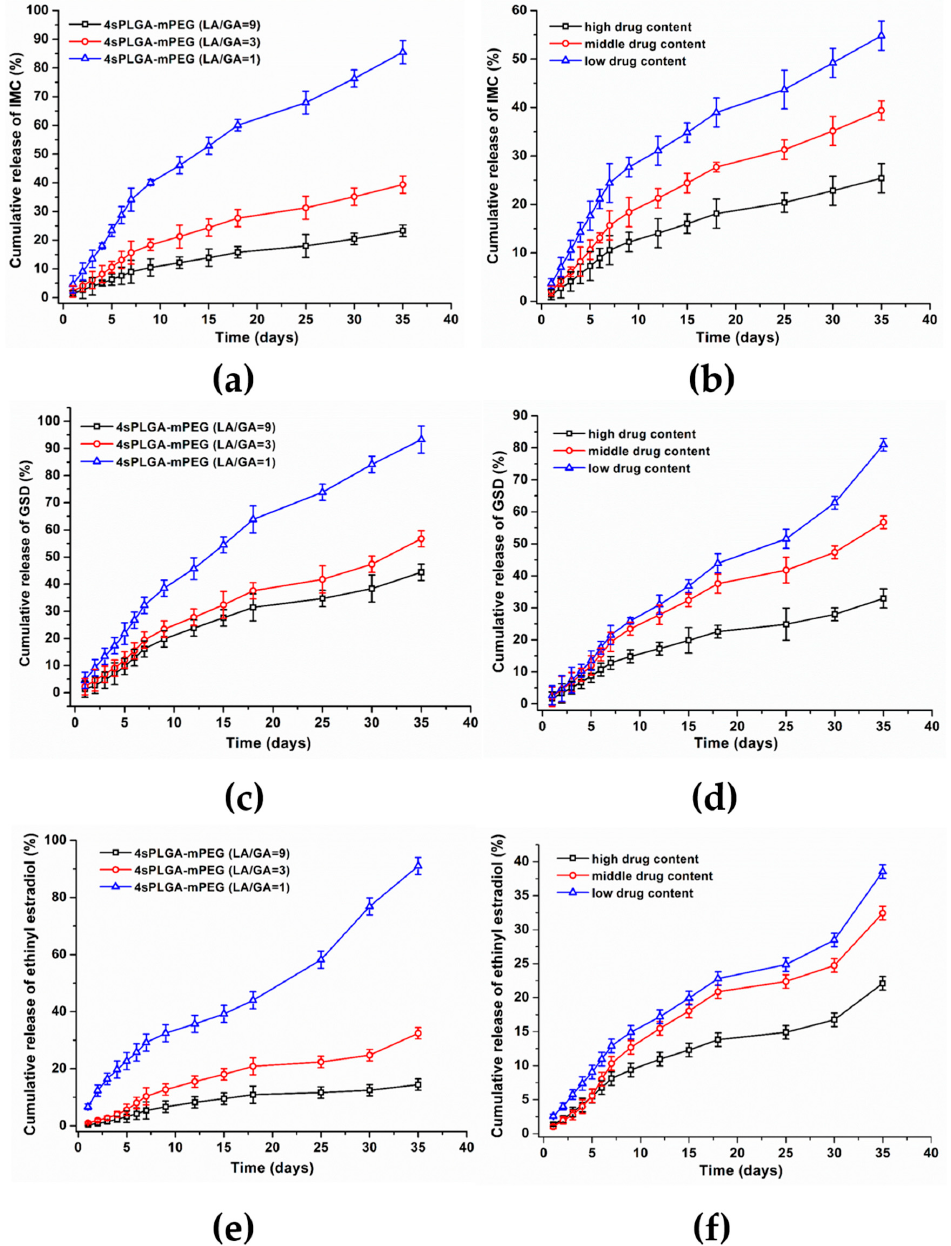
Figure 3. The release profiles of indomethacin (IMC), gestodene (GSD), and ethinyl estradiol (EE) prepared 4sPLGA-mPEG block copolymer hydrogels. Cumulative release of IMC ( a ), GSD ( b ), and EE ( c ) packed by copolymer hydrogel with the same middle drug content and various lactide / glycolide (LA / GA) mol ratios. Cumulative release of IMC ( d ), GSD ( e ), and EE ( f ) loaded by CP-2 copolymer (LA / GA = 3) hydrogel with various drug contents (high, middle, and low). Copolymer concentration was 30